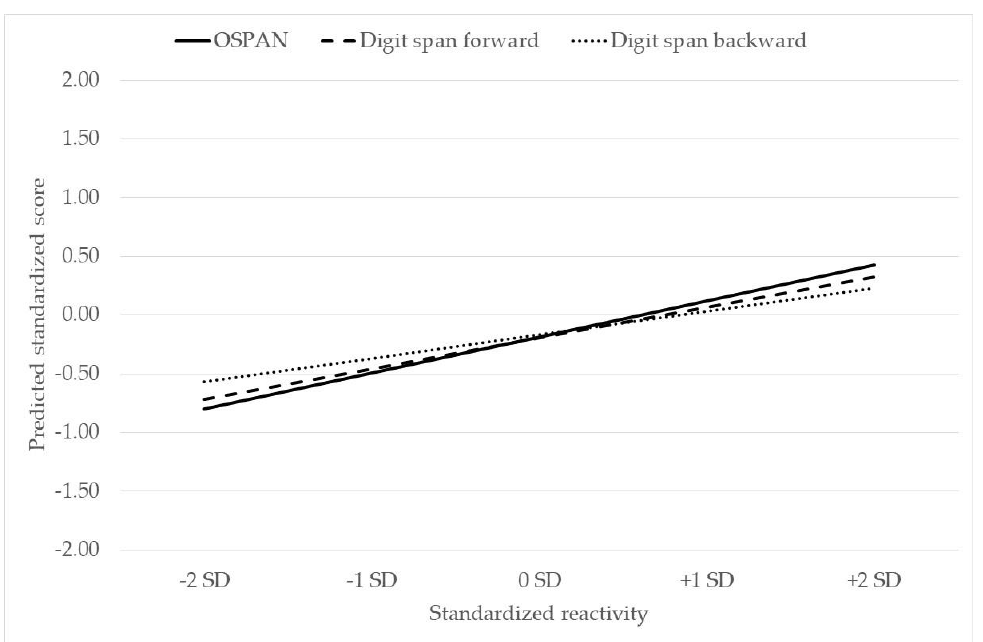
Figure 1. Predicted standardized scores for the three working memory tests (OSPAN test, digit span forward, and digit span backward) by standardized reactivity. High reactivity is indicated by two standard deviations (+2 SD) above the mean (0). Low reactivity is indicated to be two standard deviations (−2 SD) below the mean.